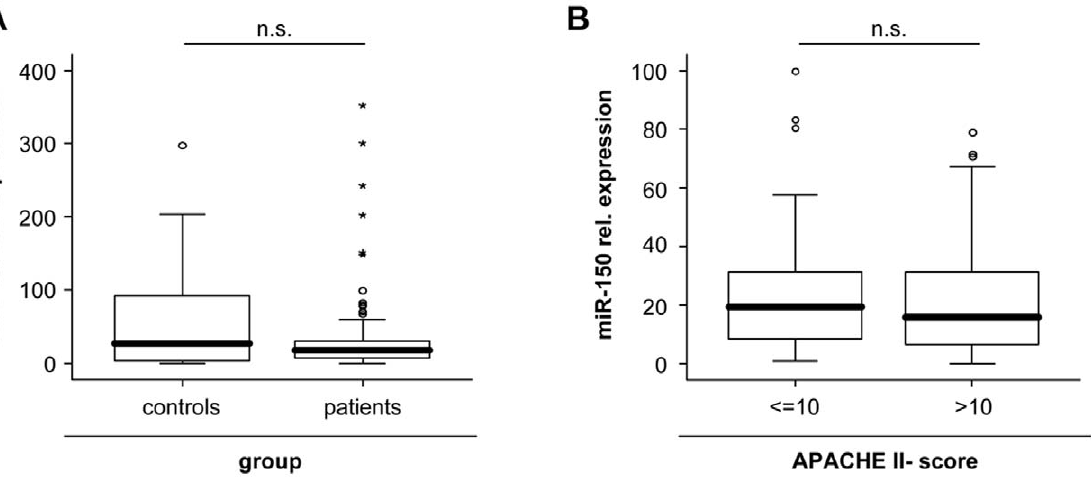
Figure 2. Serum miR-150 levels of critically ill patients at ICU admission. (A) Serum miR-150 levels at admission to the intensive care unit were analyzed by qPCR and revealed a trend toward reduced miR-150 concentrations in critically ill patients (n=223) as compared with healthy controls (n=76). (B) Serum miR-150 concentrations at admission to the ICU were not significantly changed in critically ill patients with high initial Acute Physiology and Chronic Health Evaluation (APACHE) II scores ( . 10) in comparison to patients with low APACHE-II-scores ( , /=10). Box plot are displayed, where the bold line indicates the median per group, the box represents 50% of the values, and horizontal lines show minimum and maximum values of the calculated non-outlier values; asterisks and open circles indicate outlier